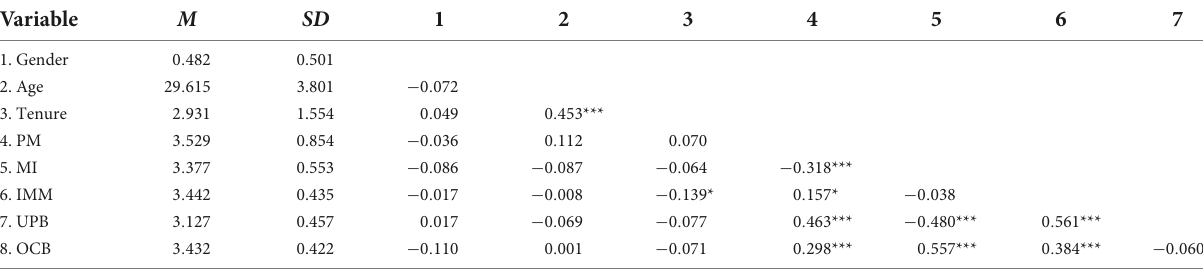
TABLE 2 Means, standard deviations, and correlations.